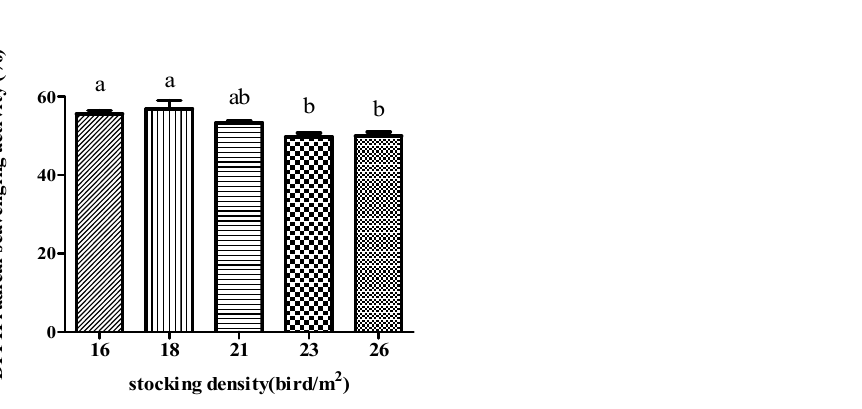
Table 4. Effect of stocking density on thiobarbituric acid (TBARS) in breast meat of broiler chickens under high temperatures during cold storage.